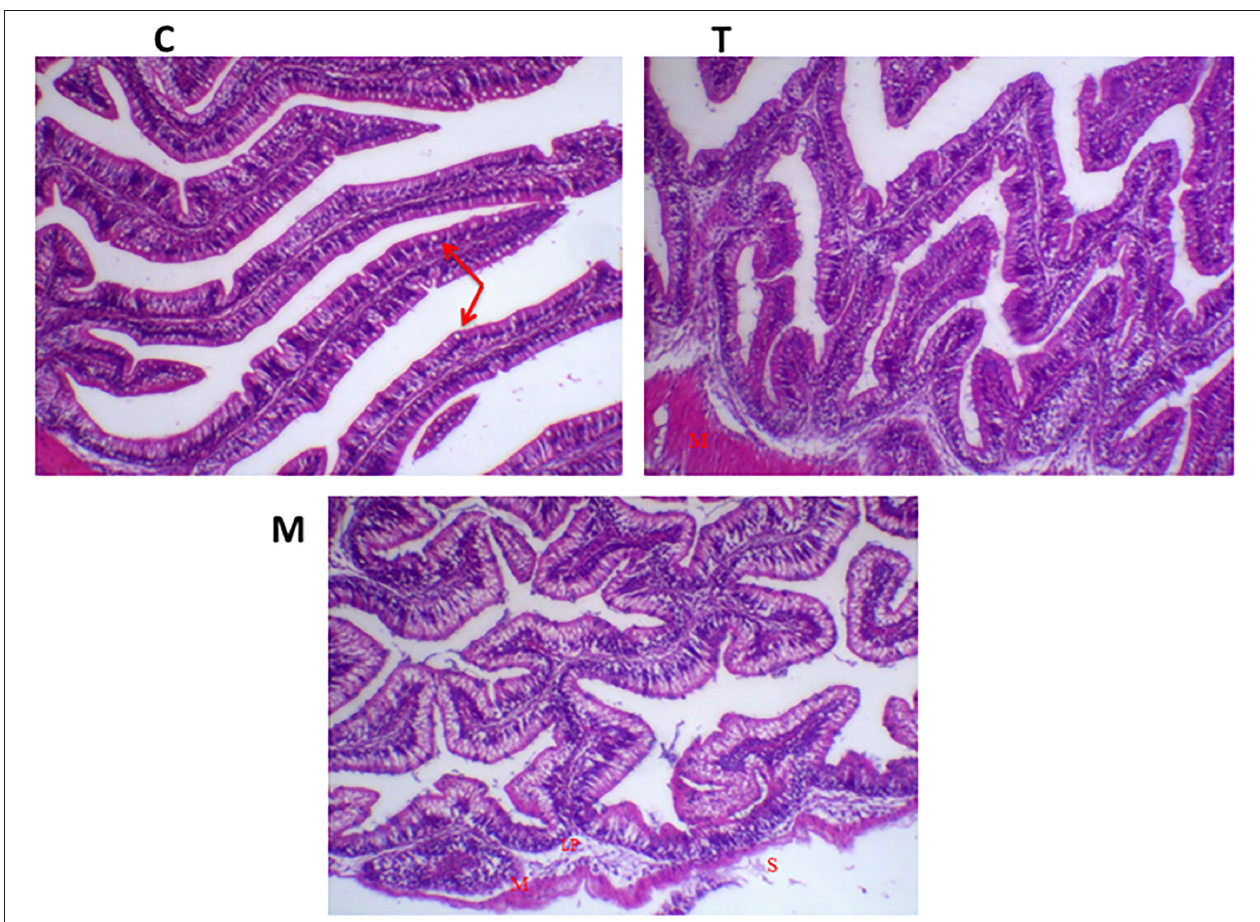
FIGURE 4 | H&E stained photomicrograph of mono-sex Nile tilapia mid-gut following moringa leaf dietary inclusion for 8 weeks under normal health conditions. C, T, and M denote the 0, 5, and 10% moringa levels, respectively. Red arrow represents goblet cells, M represents tunica muscularis, LP means lamina probria sub-mucosa, while S means tunica